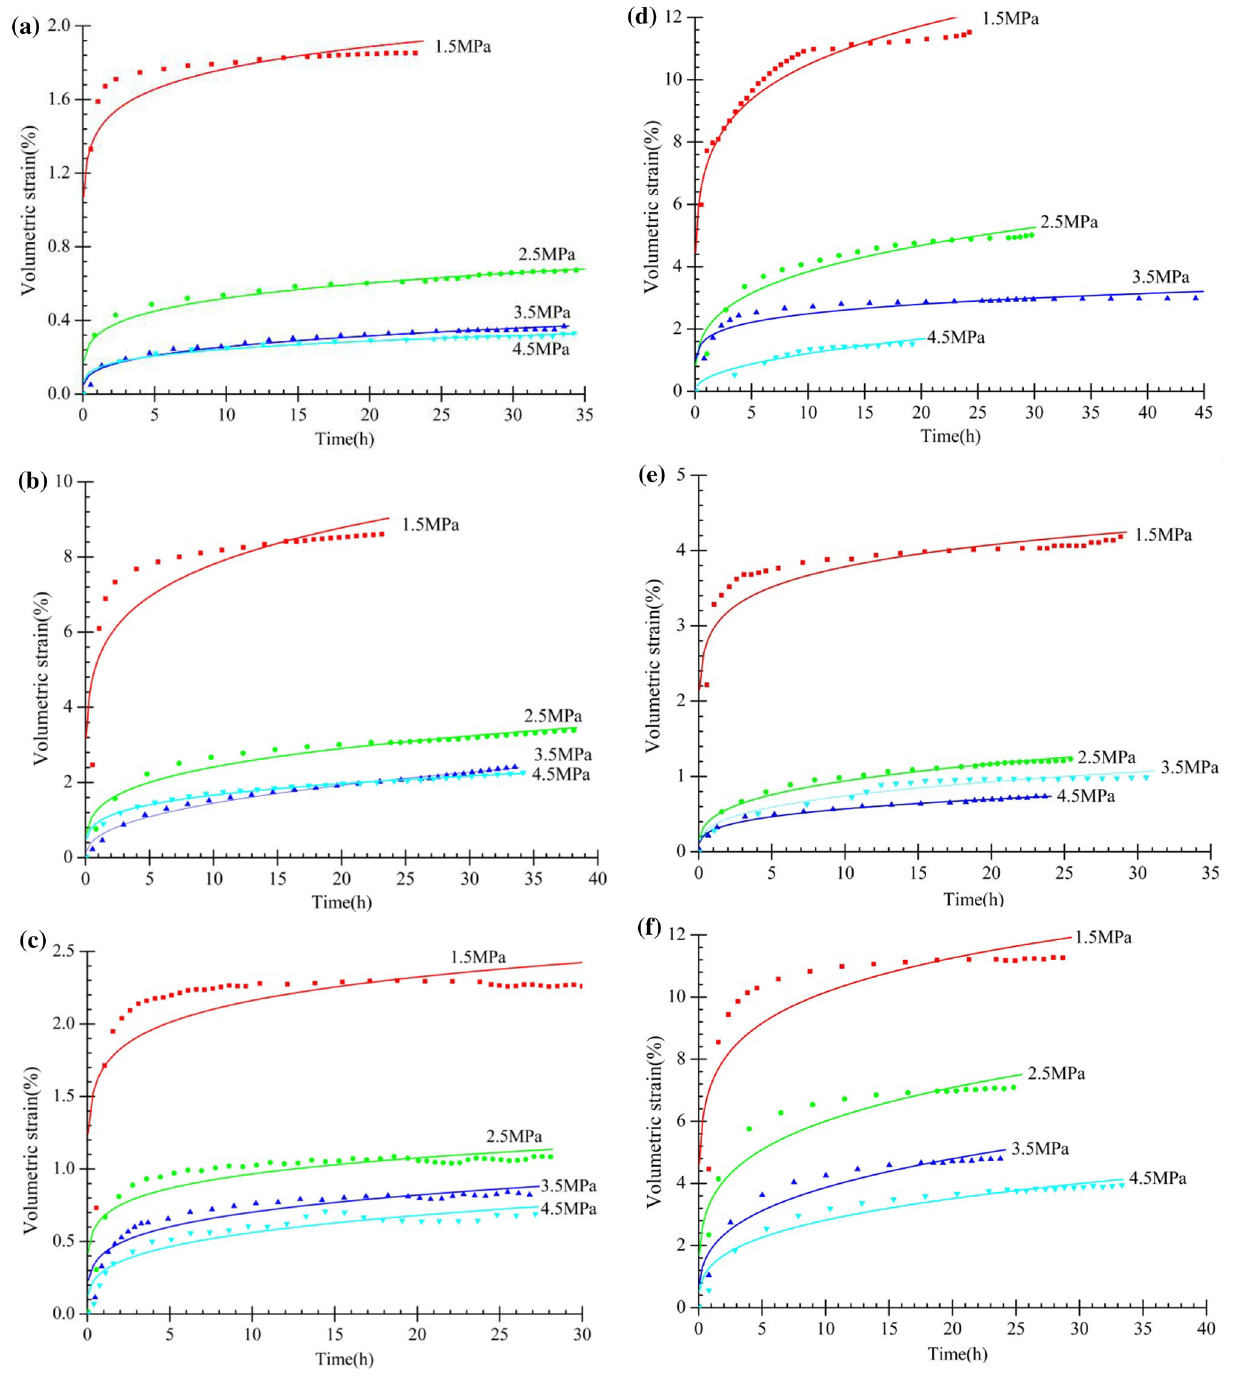
Fig. 9 Creep test results and fitting curves under different levels of loading: a Jingle laterite specimens with 1.0 mm wide cracks, b Baode laterite specimens with 1.0 mm wide cracks, c Jingle laterite specimens with 1.5 mm wide cracks, d Baode laterite specimens with 1.5 mm wide cracks, e Jingle laterite specimens with 2.5 mm wide cracks, f Baode laterite specimens with 2.5 mm wide